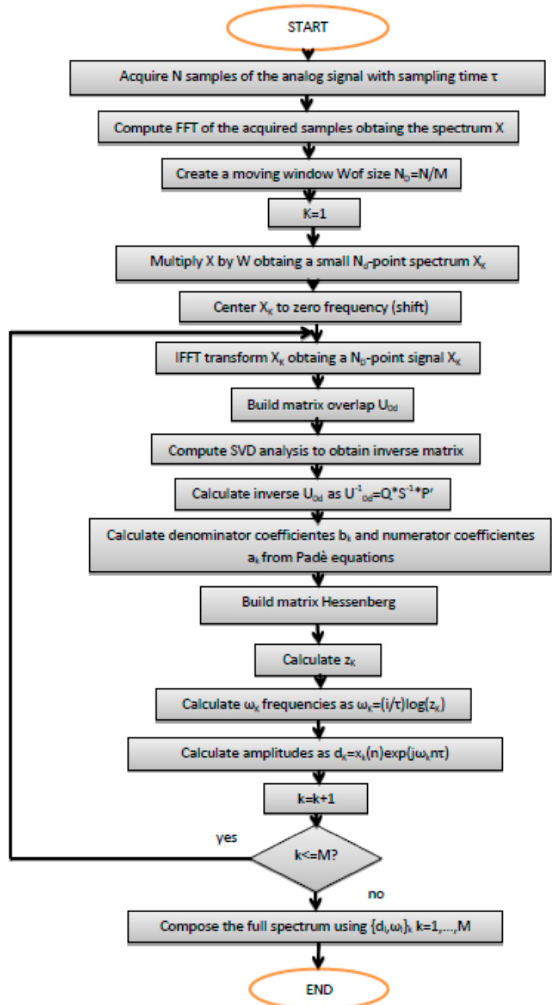
Figure 6. Summary of the decimated linear prediction (DLP) algorithm.